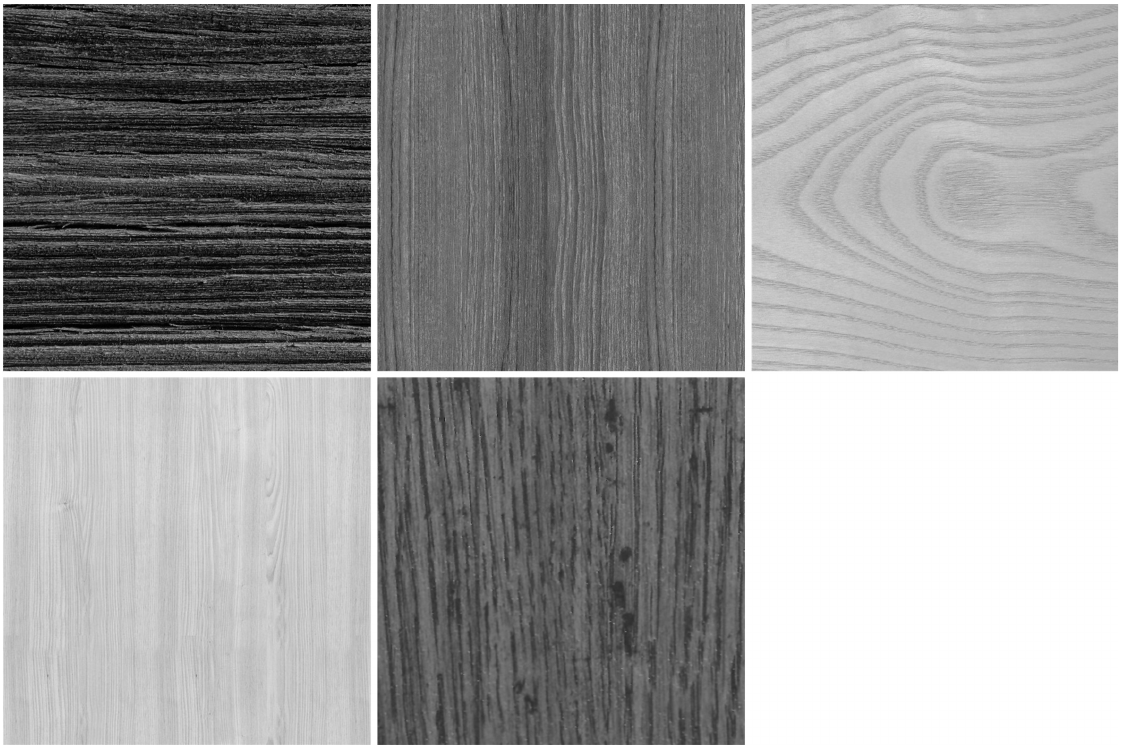
Figure 21. The set of textures for CSR measurements in Figure